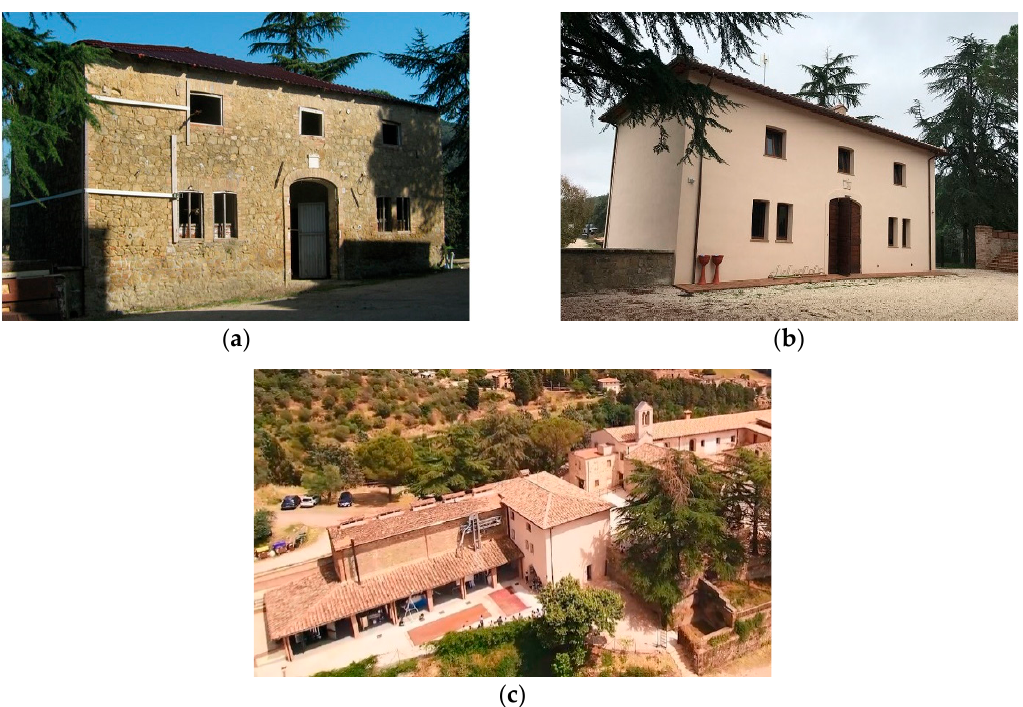
Figure 1. View of the case study building: ( a ) before the refurbishment; ( b ) after the refurbishment; ( c ) within the complex of Sant’Apollinare fortress.